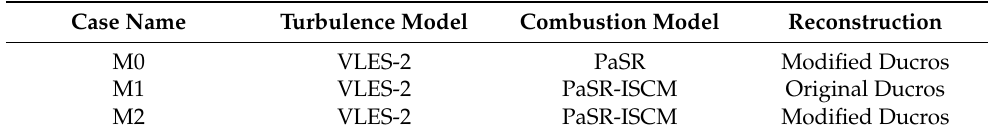
Table 2. Case setup for the very large eddy